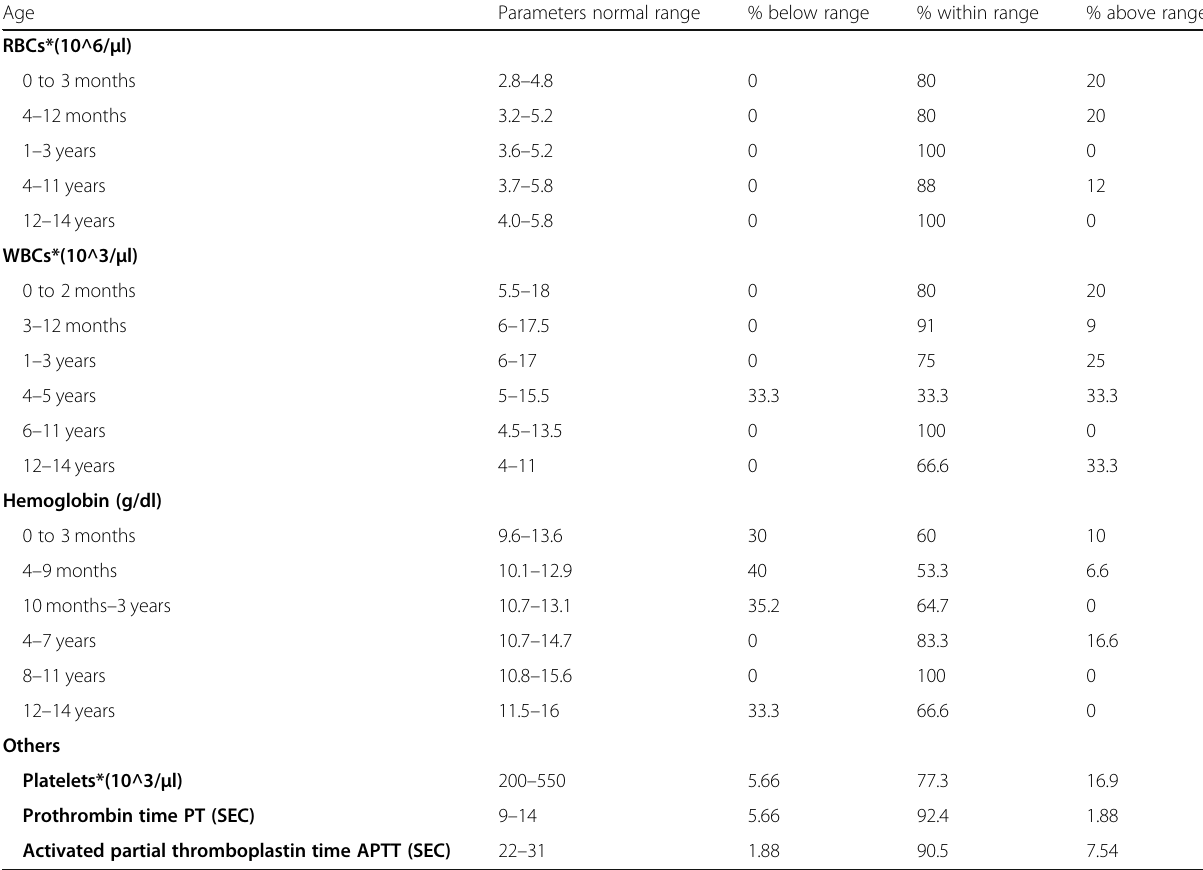
Table 1 Hematological parameters in study population